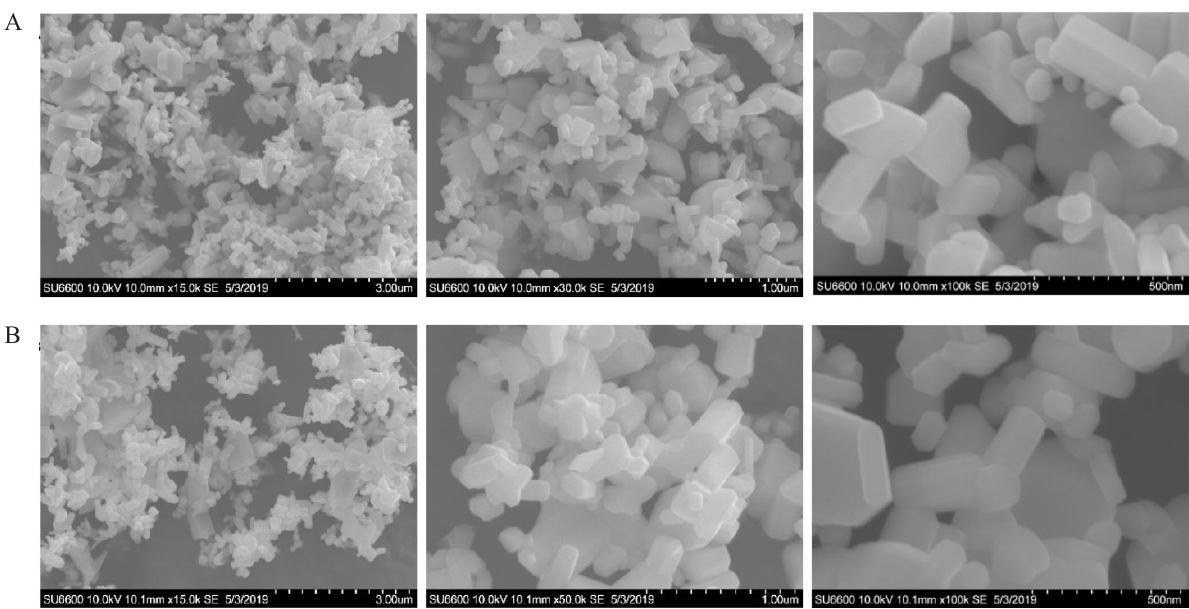
Figure 3: FE-SEM images of A) Nano ZnO particles and B) Bulk ZnO